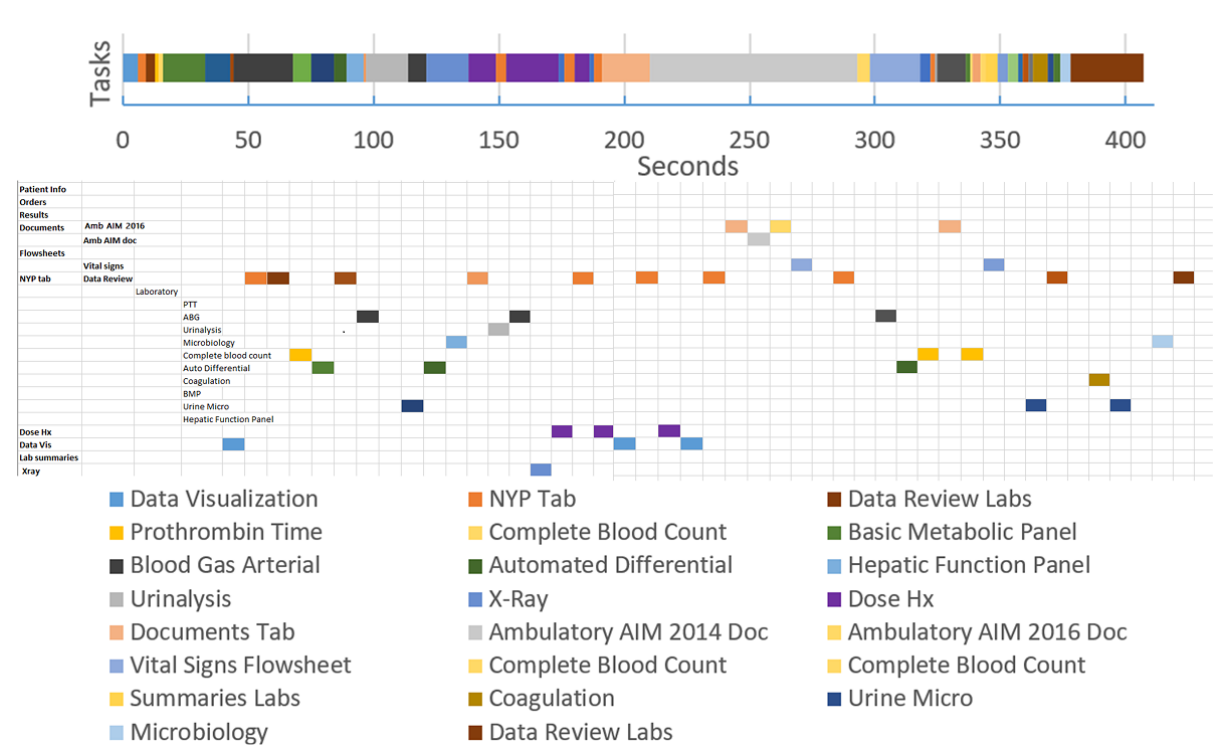
Figure 11. Color of each cell or segment represents the task or screen the user was completing in sequential order. The time belt visualization shows the time taken for each task, whereas the Excel data scheme shows the different screen or part of the system needed for each task.